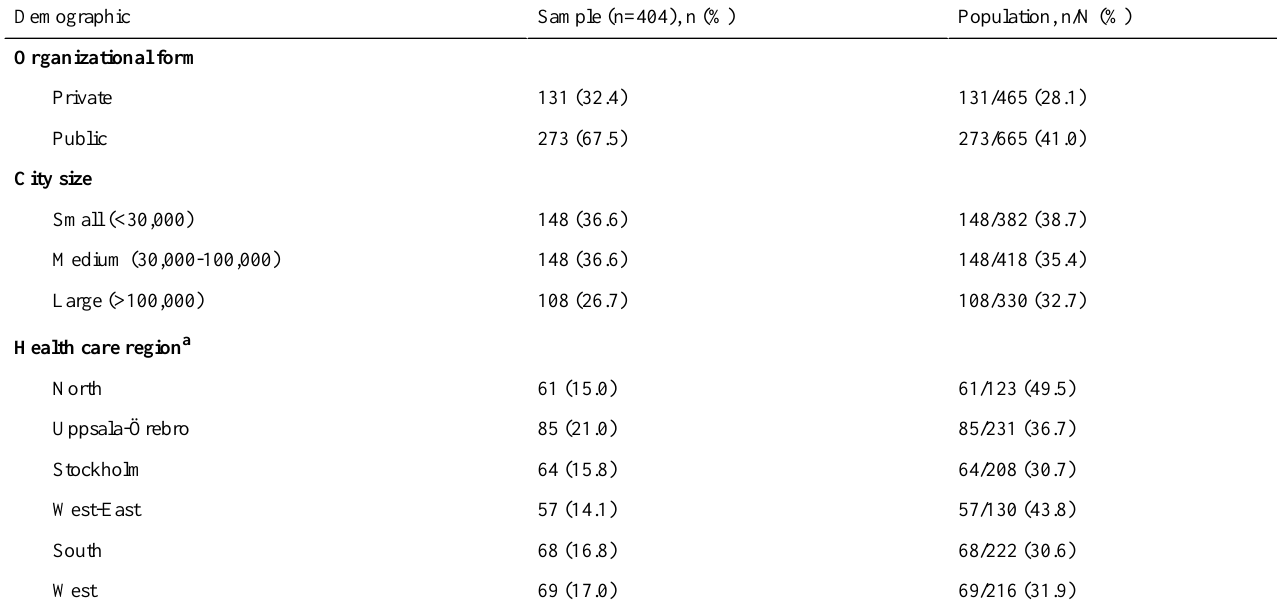
Table 1. Distribution of respondents in study sample and